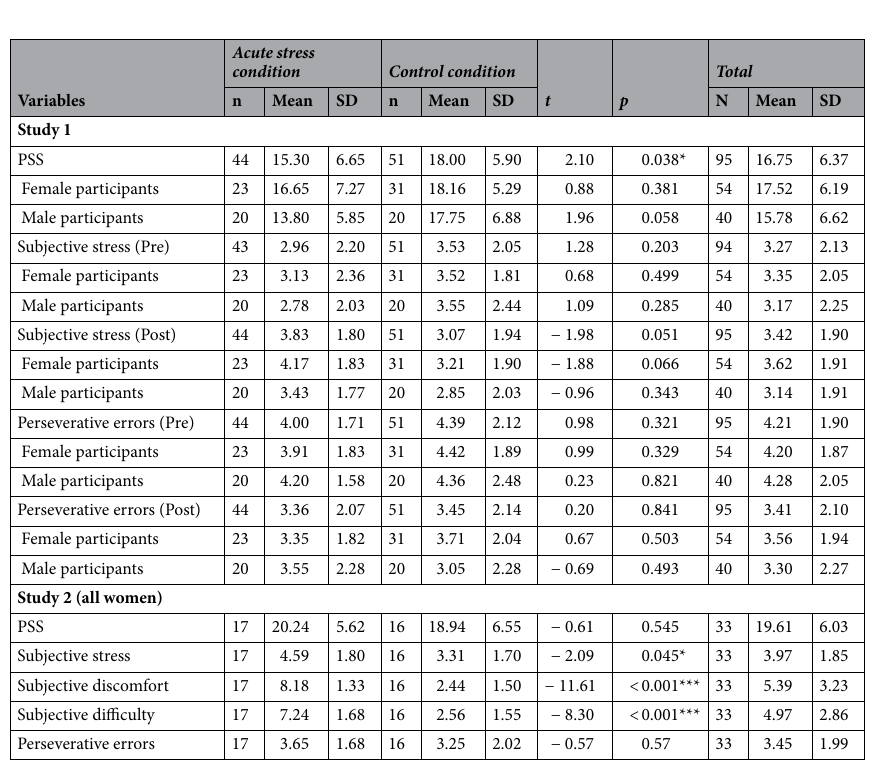
Table 2. Descriptive statistics. t- and p values indicate the magnitude of the differences between the acute stress and control condition for each variable; * p < 0.05; *** p < 0.001 measures of subjective stress, discomfort, and difficulty in Study 2 occurred following the acute stress or control